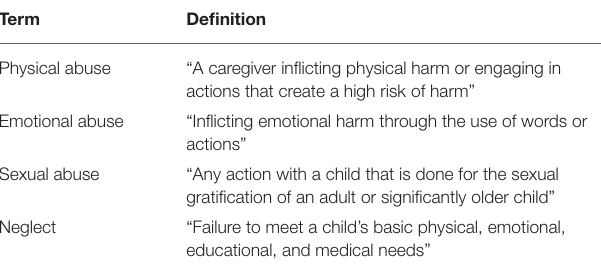
TABLE 1 | Definitions of childhood maltreatment types